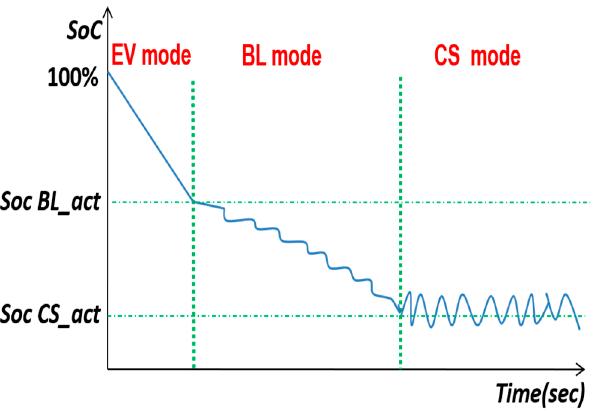
Figure 1. Variation of the state of charge of the battery during the three modes of operation for a PHEV.